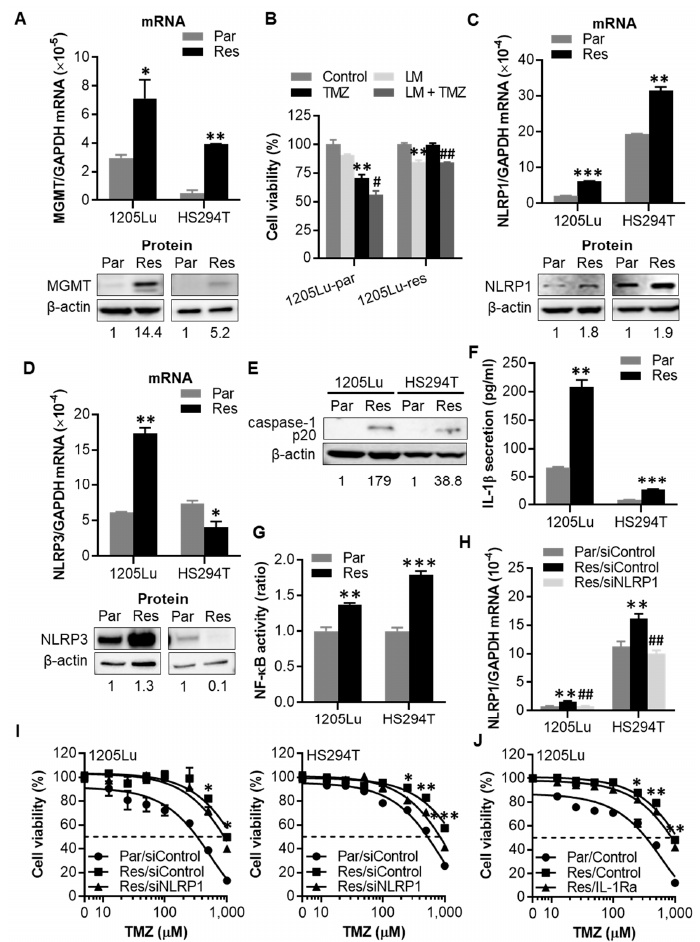
Figure 4. TMZ-resistant cells show increased NLRP1 expression and IL-1 β secretion levels. Resistant 1205Lu and HS294T cells were generated after exposing cells to stepwise increasing doses of TMZ (50–200 µM for 1205Lu and 25–100 µ Μ for HS294T) over two months. ( A ) qRT-PCR analysis of MGMT mRNA expression (upper panel) and Western blot analysis of MGMT protein expression (lower panel) in resistant cells. ( B ) Cell viability of 1205Lu parental and resistant cells evaluated by MTS assay after the treatment with a single dose of TMZ and/or a single dose of the MGMT inhibitor Lomeguatrib (LM) for 72 h. ( C ) NLRP1 mRNA (upper panel) and protein (lower panel) expression, ( D ) NLRP3 mRNA (upper panel) and protein (lower panel) expression, ( E ) caspase-1 cleavage, ( F ) IL- 1 β secretion, and ( G ) NF- κ B activity of resistant 1205Lu and HS294T cells. ( H ) NLRP1 mRNA expression in parental and resistant 1205Lu and HS294T cells at 24 h after transfection with siNLRP1. ( I ) Cell viability of parental and resistant 1205Lu (left) and HS294T (right) cells after NLRP1